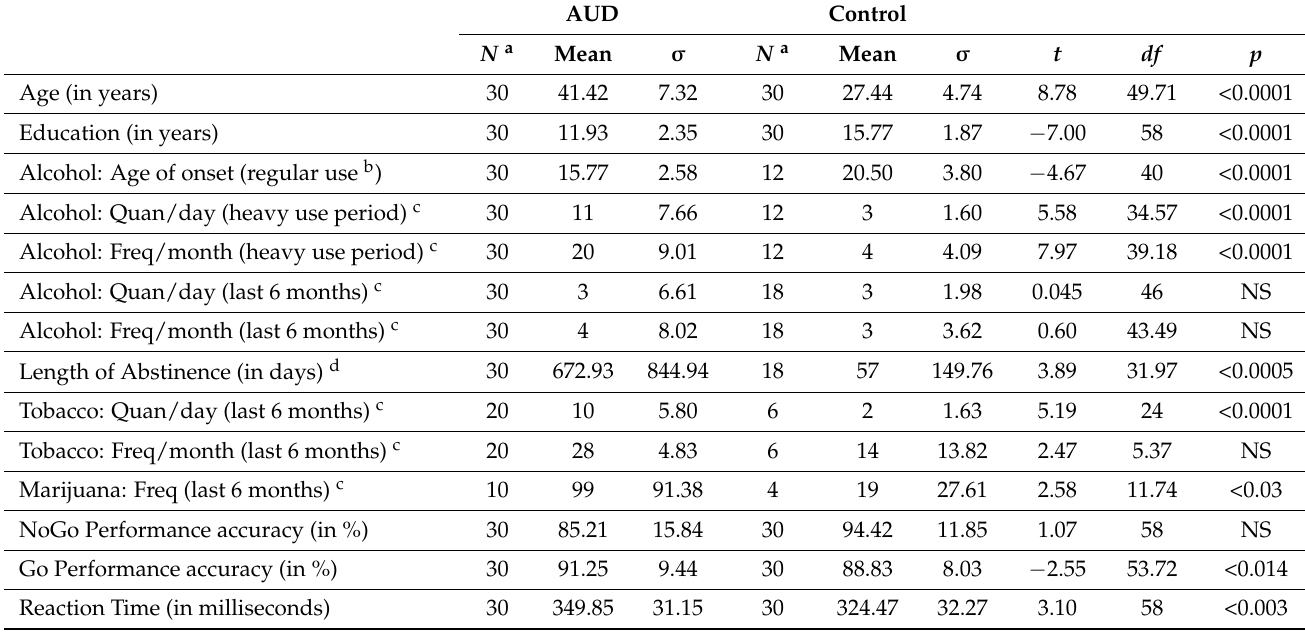
Table 1. Sociodemographic, Go/NoGo task performance, BIS-11, alcohol, and substance use profile and descriptive statistics of abstinent AUD and control